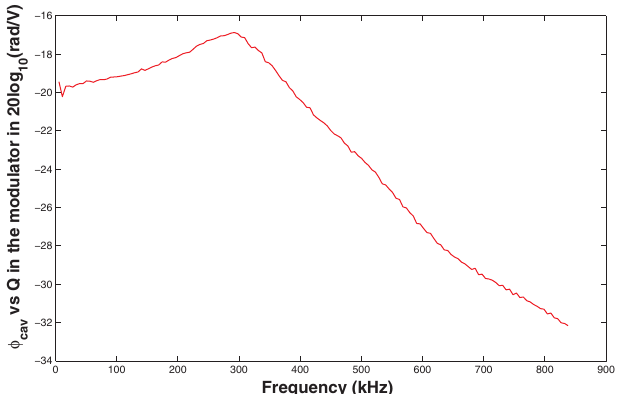
FIG. 4. (Color) The transfer function between the rf accelerating voltage phase and the noise at the q channel at the input of the ð f Þ(cid:2)gð rad =V Þ . modulator f½ (cid:1) cav ð f Þ(cid:2) = ½ n mod q